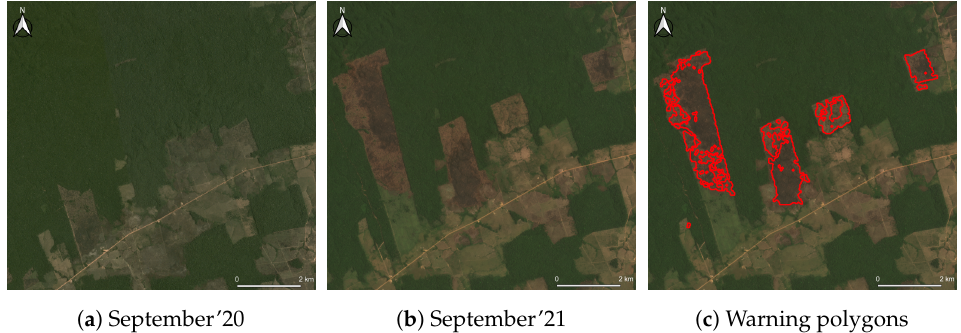
Figure 10. Example of deforestation warnings issued by the DETER-R system in September 2021 near the city of Apui (AM), besides the BR-230 (Transamazônica) highway. In this case deforestation is linked to cattle-ranching. Satellite background true-color image by Planet Labs